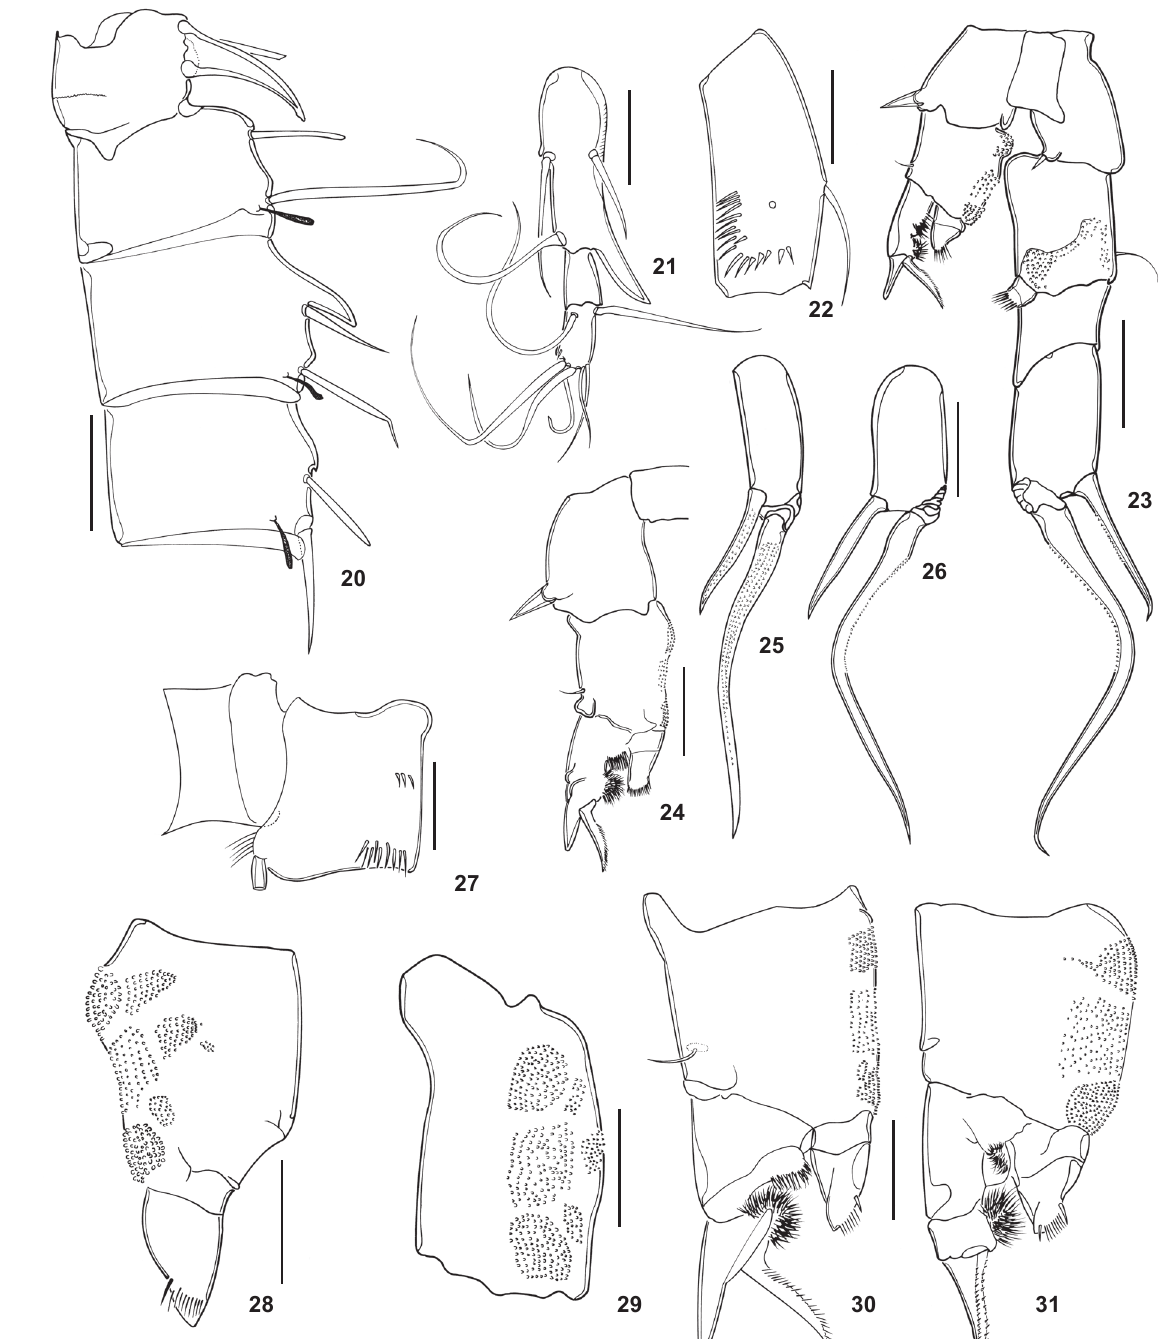
Figures 20-31. Morphological structures of Argyrodiaptomus bergi adult male: (20) segments 13-17 of right antennule; (21) terminal three segments of right antennule; (22) second segment of endopod of antenna; (23) leg 5 in caudal view; (24) endopod of leg 5 in frontal view; (25) last segment of leg 5 in lateral oblique view; (26) last segment of leg 5 in frontal view; (27) intercoxal sclerite and basis of leg 4; (28) left leg 5 in caudal view; (29) left leg 5 in caudal oblique view; (30) left leg 5 in frontal view; (31) left leg 5 in frontal oblique view. Scale bars: 20-22, 24, 25, 27-31 = 50 µm; 23, 26 = 100 ZOOLOGIA 28 (5): 551–557, October, 2011